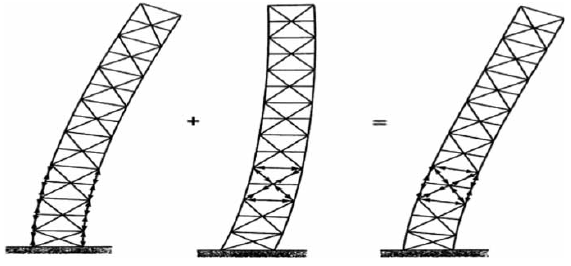
Fig. 5. Braced frame deformation (Taranath 2005)